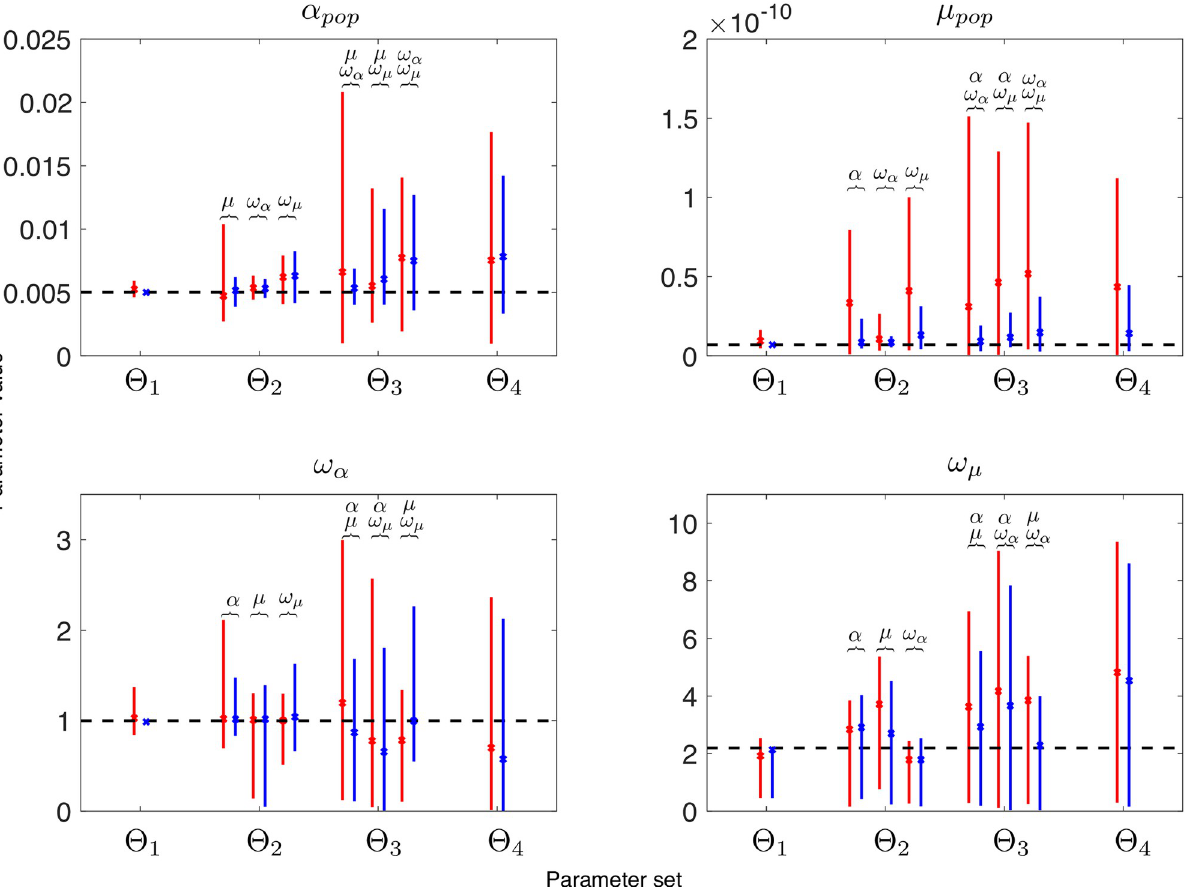
Fig 2. Mean and 95% confidence interval of each estimated parameter. The index h in Θ estimated. Red and blue lines are the estimations with the first and second objective functions respectively, corresponding to accounting for the initial proportion of metastatic patients (blue) or not (red). The dashed black lines corresponds to the true value of the parameter. The parameters that have also been estimated in each situation are displayed above the solid